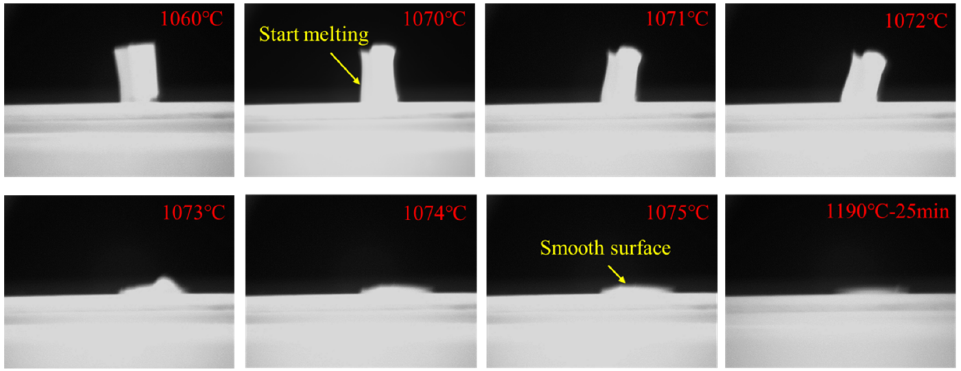
Figure 5. High-temperature contact angle on substrates of acid treatment + 4 μm Ni.